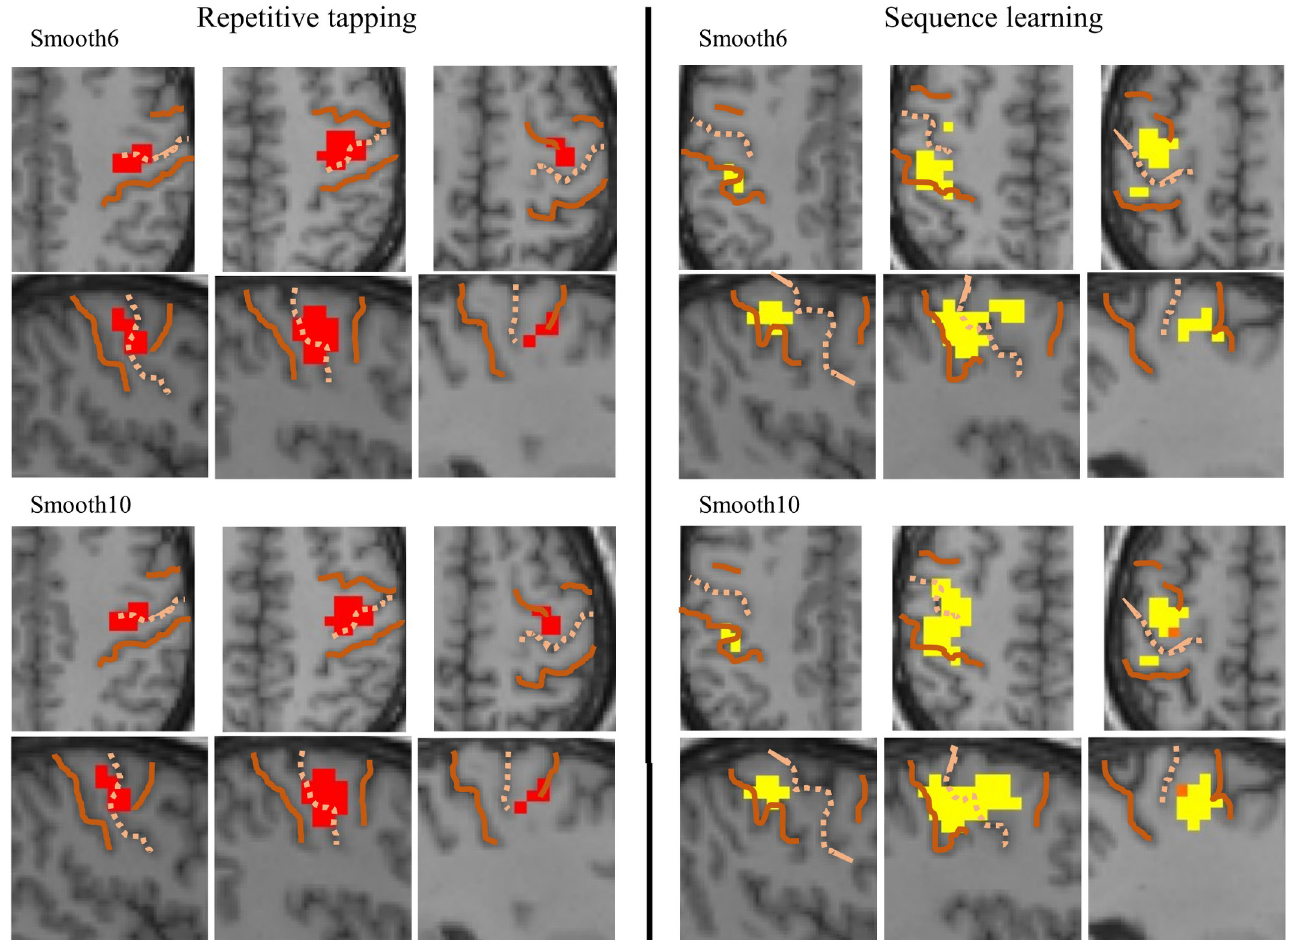
Fig 8. Hippocampal connectivity from functional seeds showing motor activity. Connectivity from functional seeds during repetitive tapping (red) or sequence learning (yellow) were similar in location and extent for both smoothing kernels.